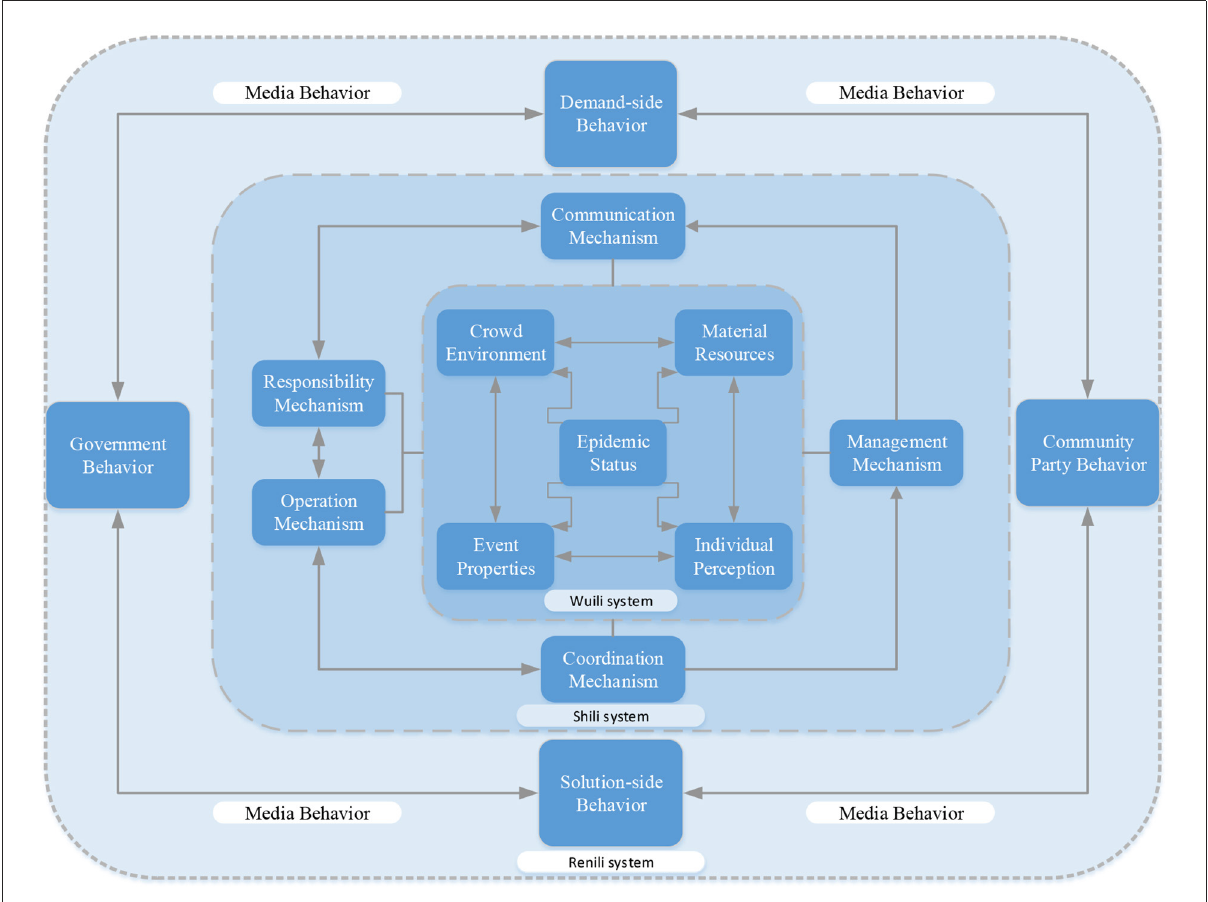
FIGURE6 WSR Elements Framework Of Network Public Opinion